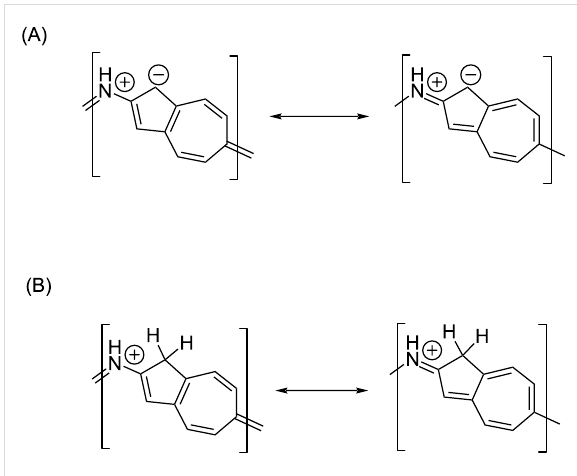
Figure 2: Iminium zwitterionic resonance forms of poly[2(6)-aminoazu- lene] 31